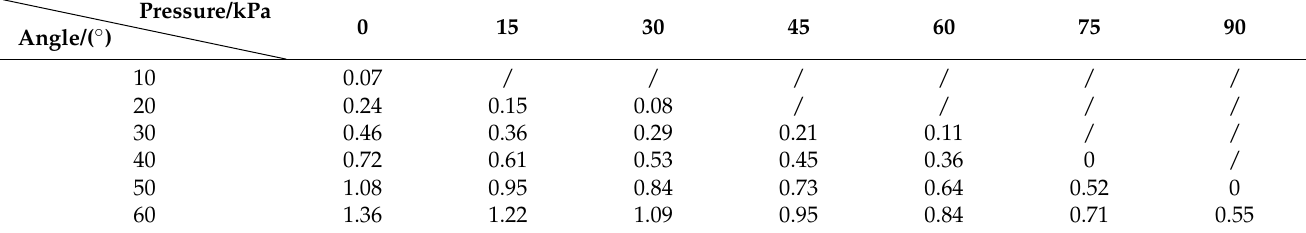
Table 1. Output force at the end of the soft actuator without constraint rings (F/N). Angle/( ◦ )